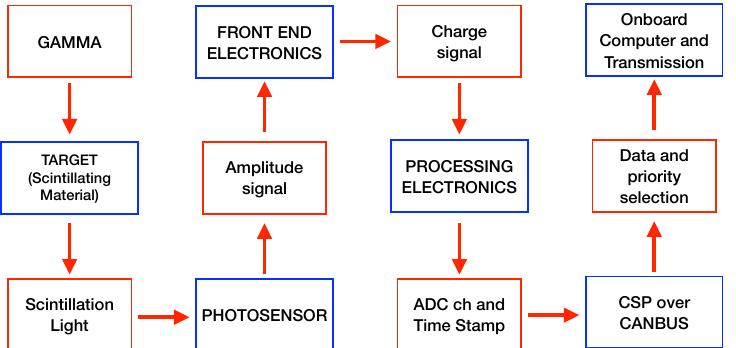
Figure 2. Schematic description of the detection concept of a gamma-ray detector operating in a Cube- Sat type satellite. The gamma-ray enters the payload and deposits energy in the target. The energy is in turn transformed into a flash of light that is collected from the photosensor. The signal output is read out by the front-end electronics and a charge signal generated. The processing electronics assigns a time stamp and a Attitude Determination and Control (ADC) channel to the event. The processed event is in turn sent to the On-Board Computer (OBC), a priority is assigned based on a look-up table for event categorization, and eventually made available for the transmission to ground.